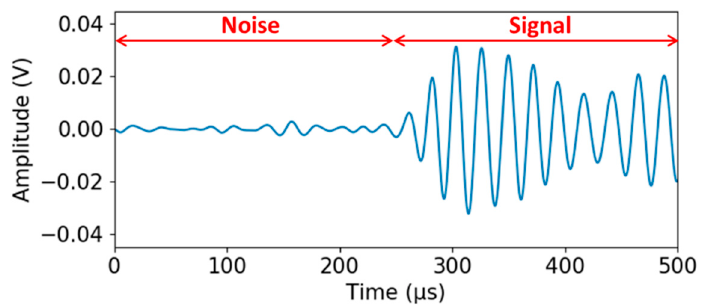
Figure 3. Example time domain surface wave signal collected from the pristine sample (Case 0).